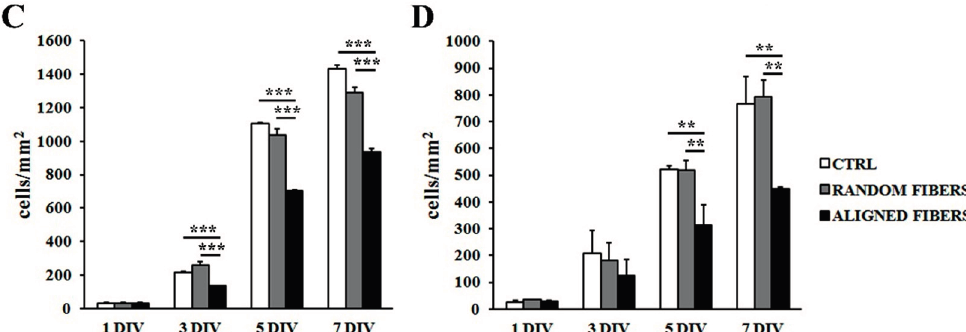
Figure 3. Proliferation assay: Fluorescent images (20× magnification) after DAPI (blue) and phalloidin (red) staining of RT4-D6P2T ( A ) and primary SC ( B ) on poly- L -lysine coated coverslips (control condition), random fibers and aligned fibers after 1, 3, 5, and 7 DIV (days in vitro ) after seeding. Scale bar: 100 μ m; RT4-D6P2T ( C ) and primary SC ( D ) cell number is expressed as cells/mm 2 ± standard error of the mean (SEM). Asterisks refer to significant statistical difference with ** p ≤ 0.01 and *** p ≤ 0.001.